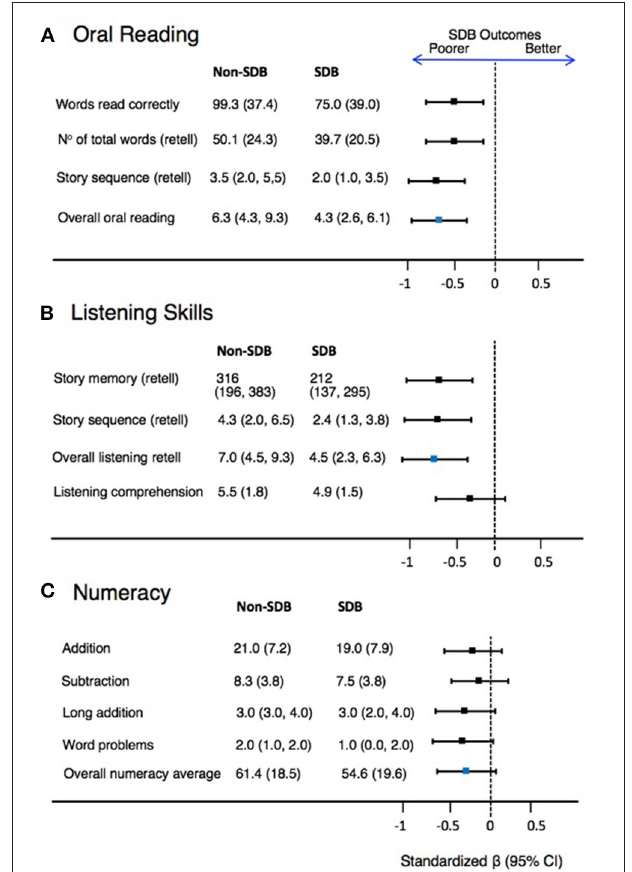
FIGURE 2 | Descriptive statistics and standardized ß regression coefficients (bars represent 95% CI) for academic outcomes (panels A to C ) at age 8 between SDB (cases) and non-SDB (controls) at age 3 ( n = 143). Anything to the left of the dashed line (showing zero difference) indicates poorer academic outcomes at age 8 for those children who were identified to have SDB at age